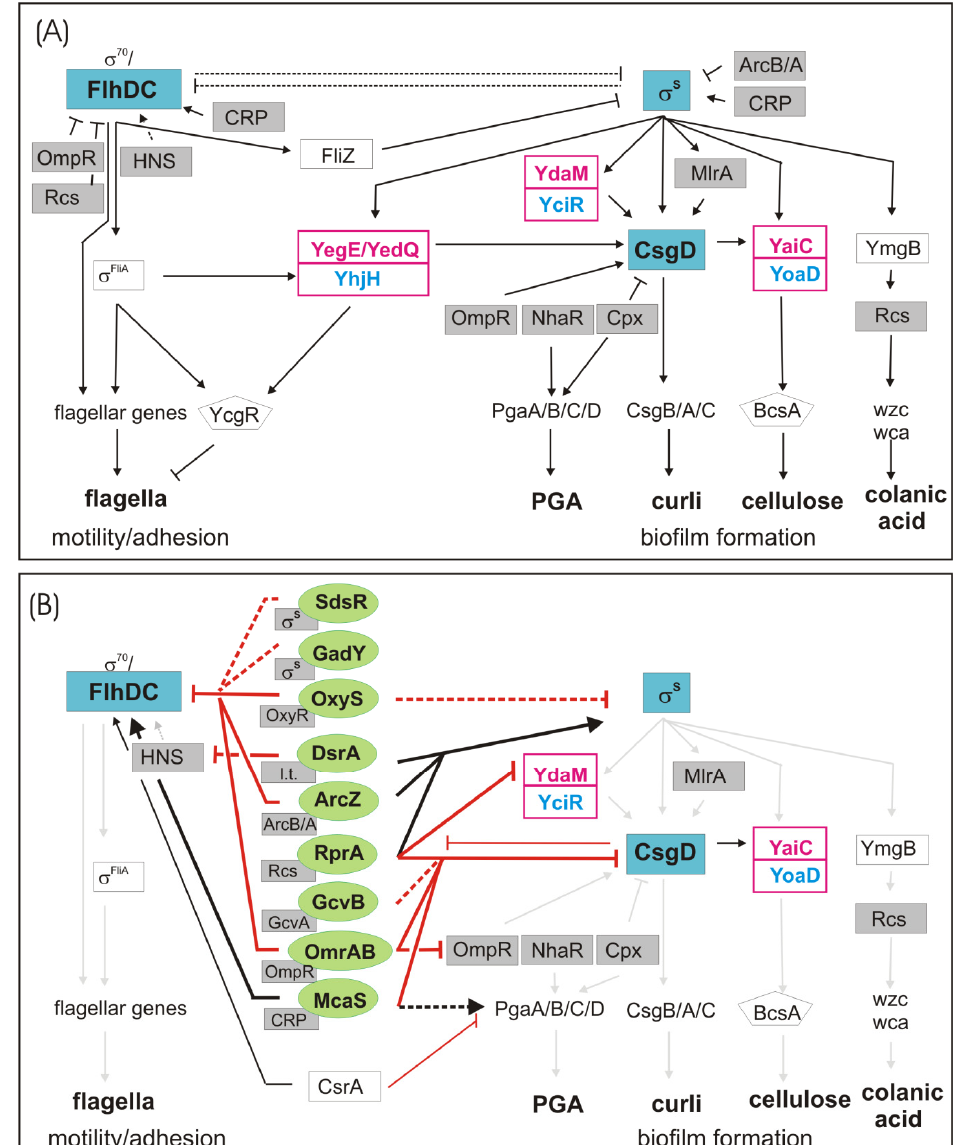
Figure 1. Motility and biofilm control networks in E. coli. ( A ) Transcriptional network, that controls switching between motility and biofilm formation. ( B ) sRNA network, that controls motility and biofilm formation at the mRNA level. Regulatory effects within the transcriptional network (grey arrows) are shown only in part due to space constraints. For distinct regulatory motifs and their function within the entire network, see Figure 3. Blue boxes: targets with “hub” mRNAs/proteins; grey rectangles: transcription factors; pentagon: c-di-GMP-binding effector protein; red boxes: c-di-GMP signaling modules (red letters: diguanylate cyclase, blue letters: phosphodiesterase); green ovals: sRNAs; dotted lines: indirect effects; straight lines: direct